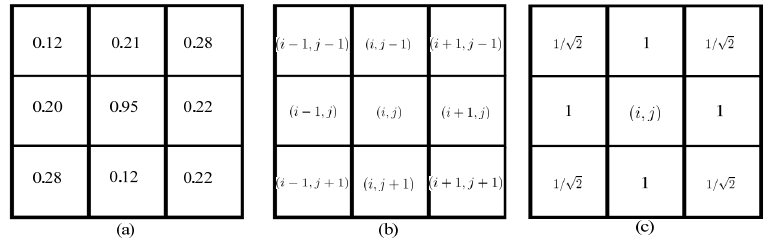
Figure 3. ( a ) Example of an undesirable configuration of membership; ( b ) Second-order neighborhood system of pixel ( i , j ); ( c ) Distances between center pixel ( i , j ) and its